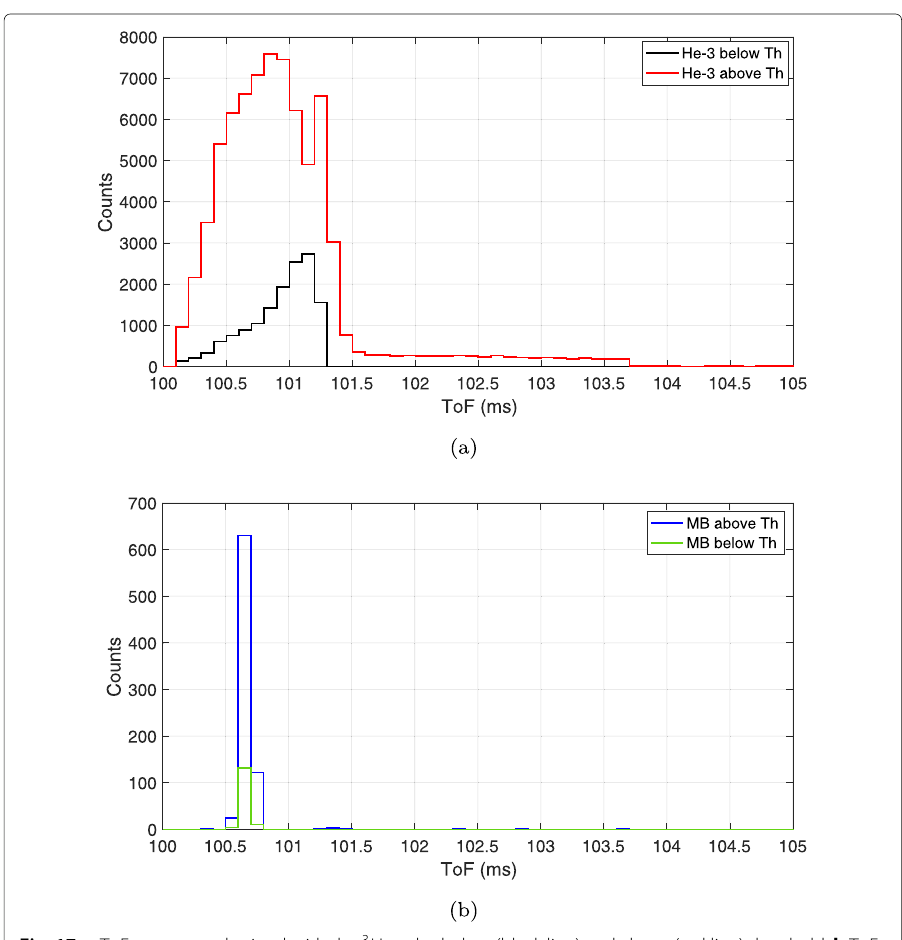
Fig. 17 a ToF spectrum obtained with the 3 He-tube below (black line) and above (red line) threshold. b ToF spectrum obtained with the the Multi-Blade detector below (green line) and above (blue line) threshold. Both are recorded in ToF range between 100 to 105 ms, i.e., when the neutron beam hits against the chopper